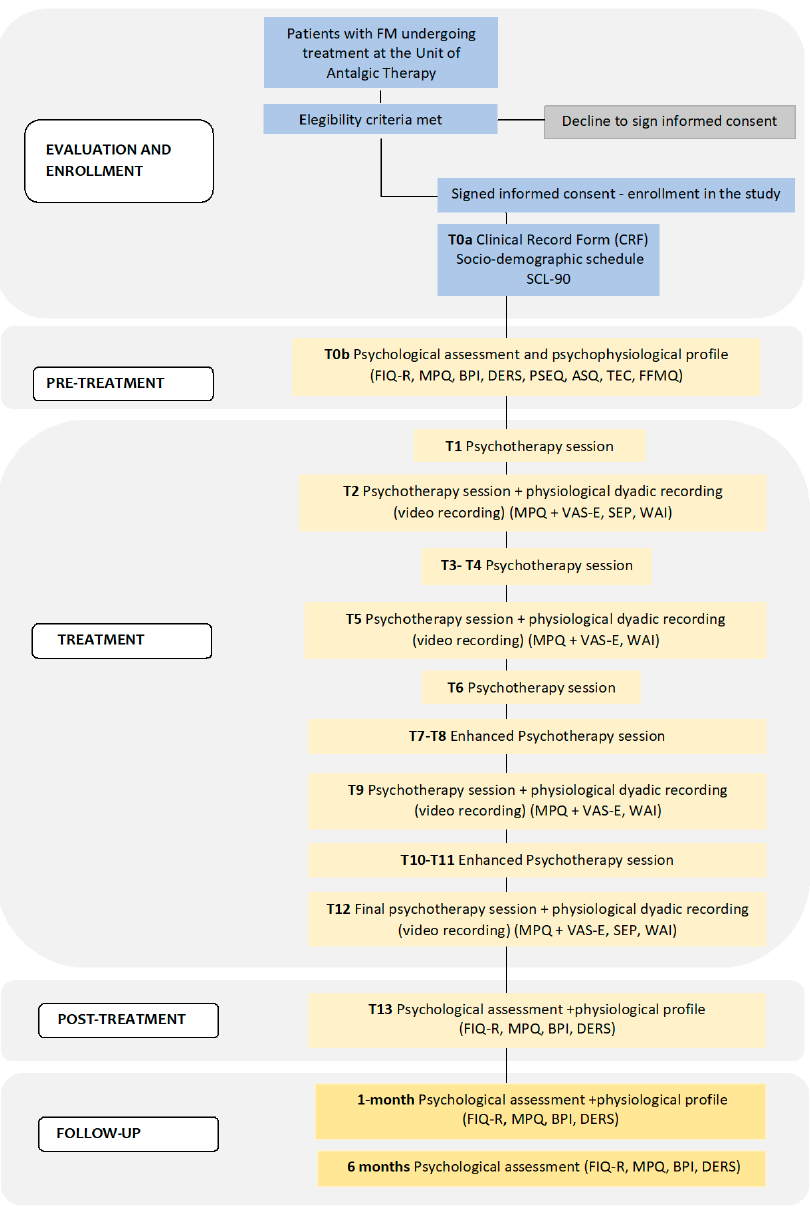
Figure 1. Flowchart of INTEGRO study.